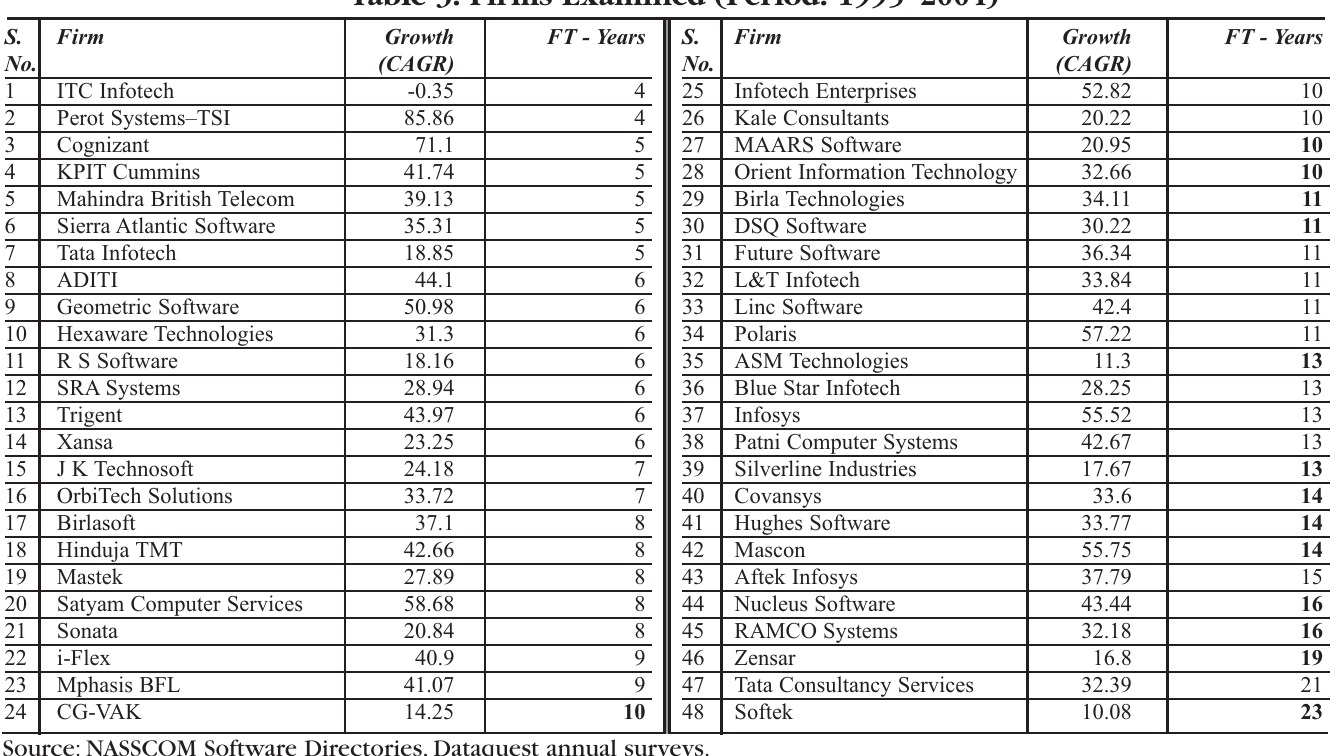
Table 3. Firms Examined (Period: